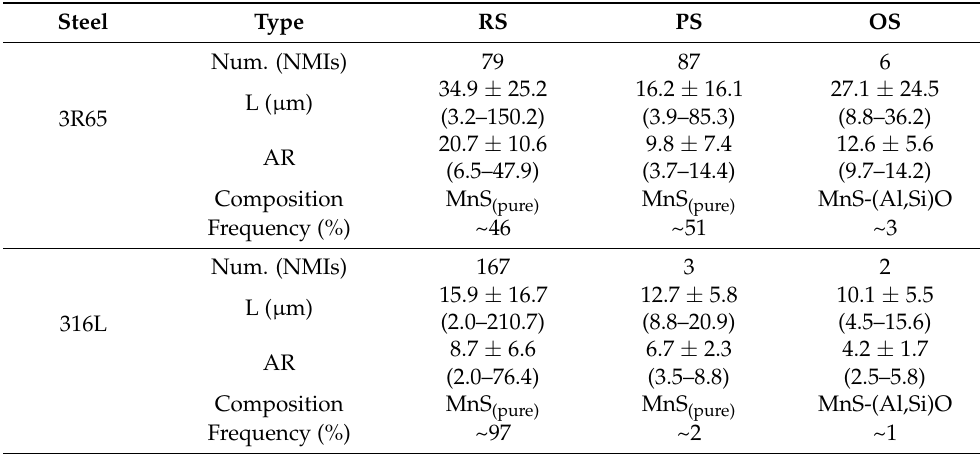
Table 4. Classification of different nonmetallic inclusions in 3R65 and 316L samples when using Method 2.